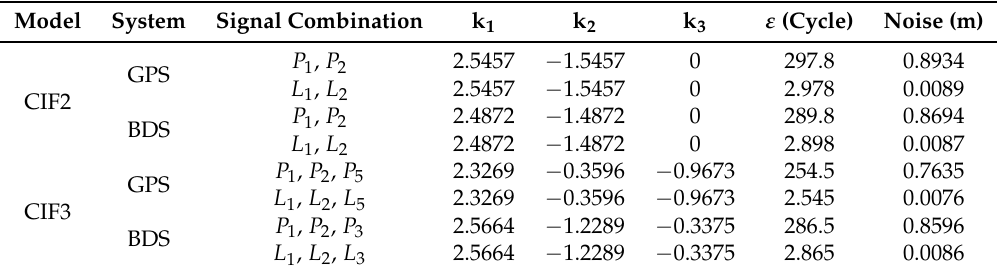
Table 2. Combinations coefficients of different fundamental signals in CIF2 and CIF3 for GPS and BDS. As to measurement noise (m), it is defined as σ P = 0.3 m, σ L = 0.003 m in both the Global Positioning System (GPS) and BeiDou Navigation Satellite System (BDS).